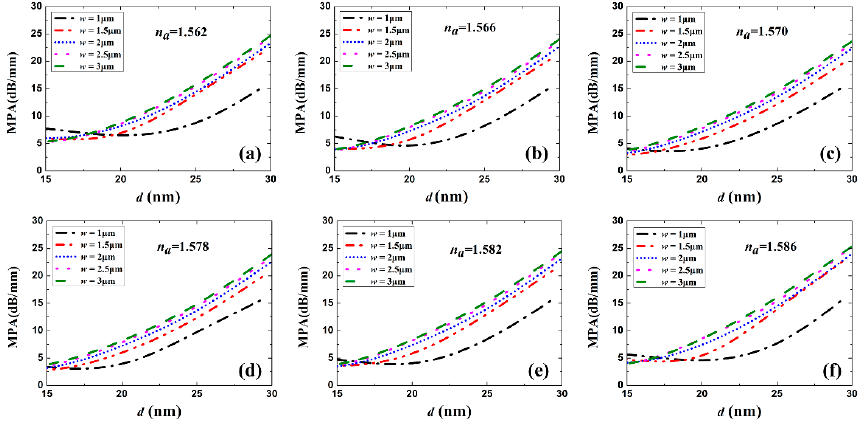
Figure 4. MPA as a function of Au stripe thickness d for different stripe widths w and sensing solutions with n a of ( a ) 1.562, ( b ) 1.566, ( c ) 1.570, ( d ) 1.578, ( e ) 1.582 and ( f ) 1.586.